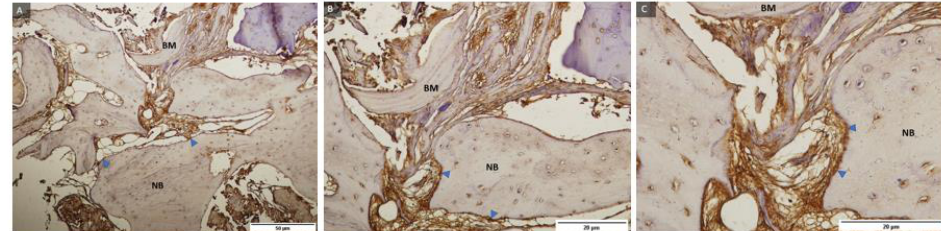
Figure 7. Examples of preparations of the control group ( A – C ) and BMP-2 immunohistochemical staining of bone sections after implantation of BMP-2 protein with labeled newly formed bone (NB), residual biomaterial (BM), and cells with expression level 3 (+++) BMP- 2 (blue marked triangle). 100, 200, and 400× magnification.